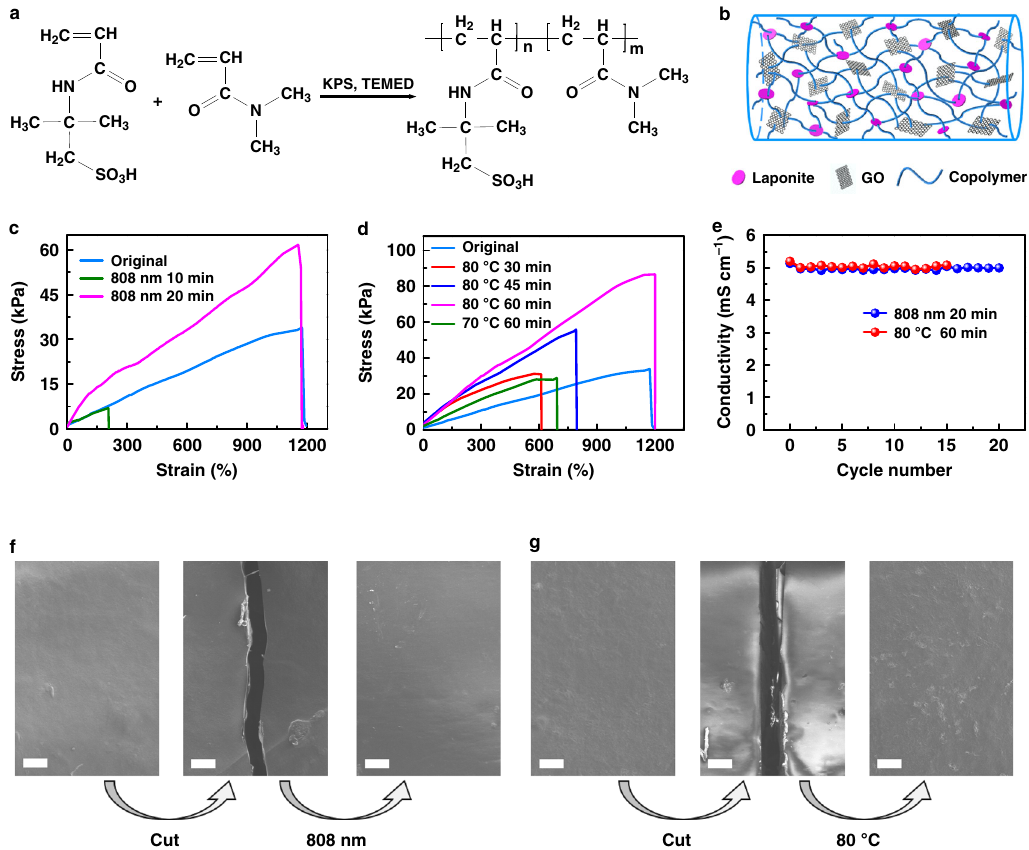
Fig. 1 Synthesis and properties of the nanocomposite hydrogels. a Schematic of copolymerization of poly(AMPS-co-DMAAm) with potassium persulfate (KPS) and N , N , N ’ , N ’ -tetramethylethylenediamine (TEMED) served as initiator and catalyst, respectively. b Schematic of poly(AMPS-co-DMAAm)/ Laponite/graphene oxide (GO) nanocomposite hydrogels with Laponite and GO served as cross-linkers. c , d Healable property of hydrogels under irradiation of 808 nm infrared light for 20 min ( c ) and heating treatment at different temperature ( d ). e Electrical conductivity retention of a hydrogel fi lm after cyclic broken/healed process. f , g Scanning electron microscopy (SEM) images of poly(AMPS-co-DMAAm)/Laponite/GO hydrogels being healed by treatment of 808 nm infrared light irradiation for 20 min ( f ) and 80 o C for 60 min ( g ). The scale bar: 100 μ